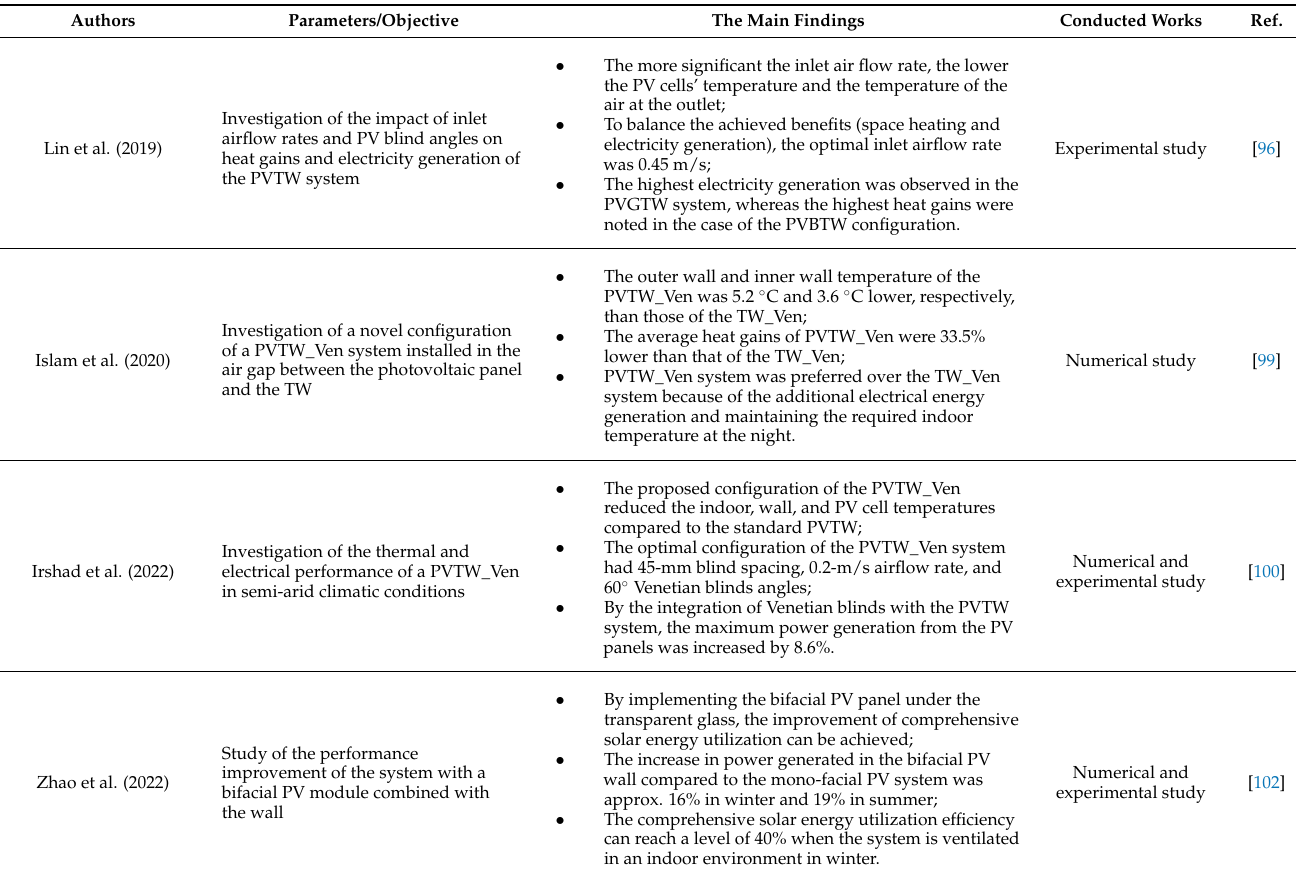
Table 4. The summary of works focused on the photovoltaic Trombe